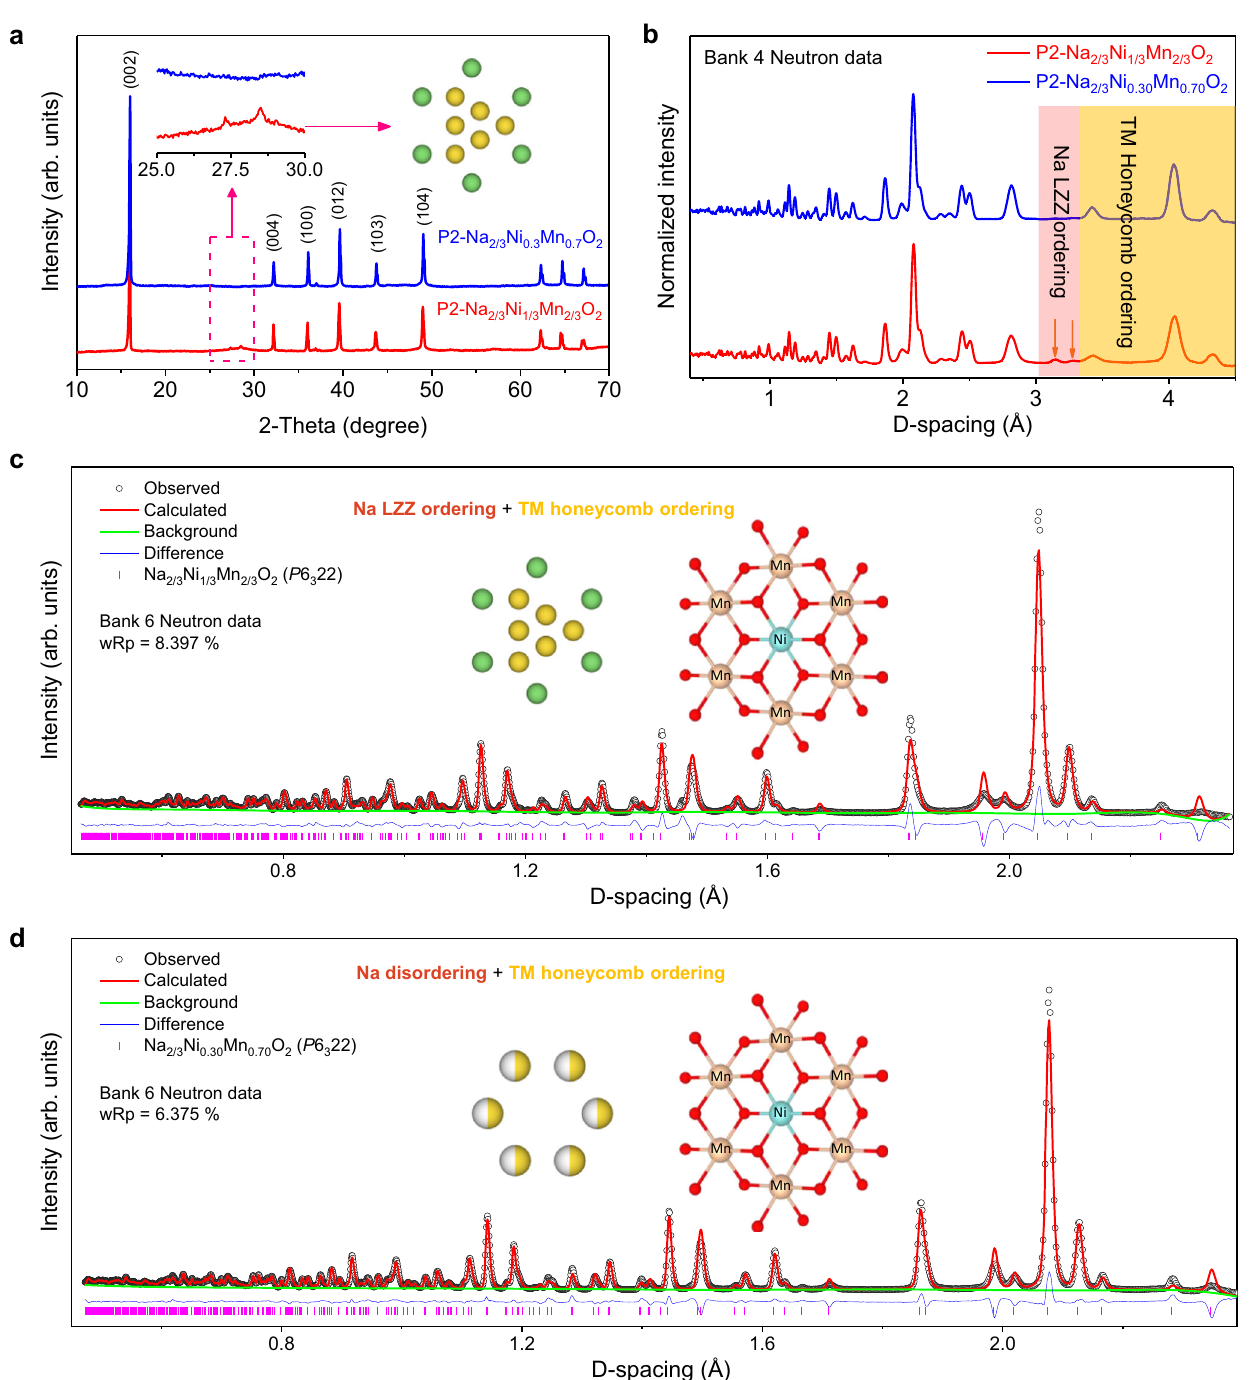
Fig.1|Disruptingthein-planeNa + /vacancyorderinginlayeredP2phaseunder perturbation. a XRD patterns of the as-prepared P2-Na 2/3 Ni 1/3 Mn 2/3 O 2 and P2- Na 2/3 Ni 0.3 Mn 0.7 O 2 sintered at 950°C for 15h, including the loss of in-plane Na + / vacancy ordering in P2-Na 2/3 Ni 0.3 Mn 0.7 O 2 . b NPD patterns of the as-prepared P2-Na 2/3 Ni 1/3 Mn 2/3 O 2 and P2-Na 2/3 Ni 0.3 Mn 0.7 O 2 samples. Re fi ned NPD patterns